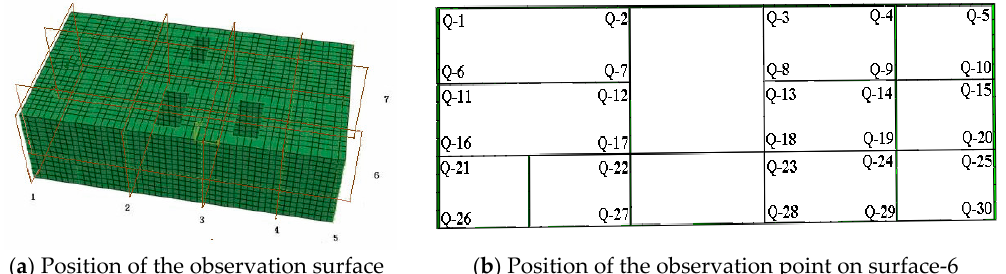
Figure 17. Position of the observation surface and point. Table 5. The peak internal forces of each section on surface-6.